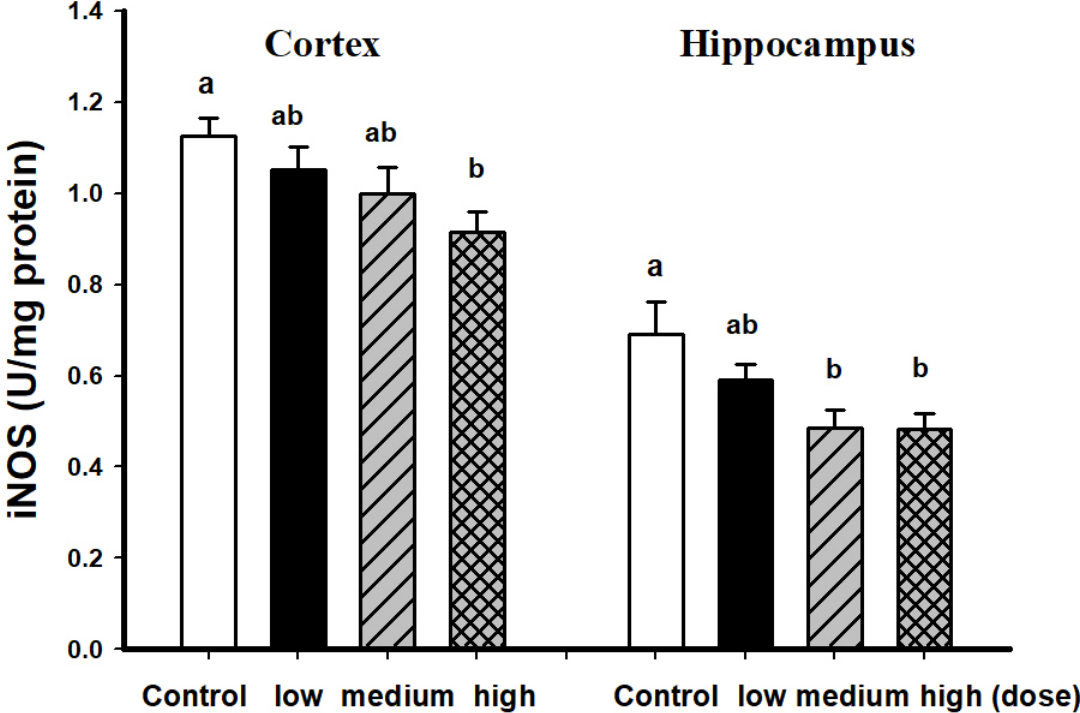
Figure 3. iNOS activity in male mice brain after 13 weeks feeding. Low dose group (108 mg/kg/bw/day), intermediate dose group (215 mg/kg/bw/day), high dose group (431 mg/kg/bw/day). Values are expressed as mean ± S.E.M. and analyzed by one-way ANOVA ( n = 5). Groups with different letters denote significant difference between each group ( p < 0.05).